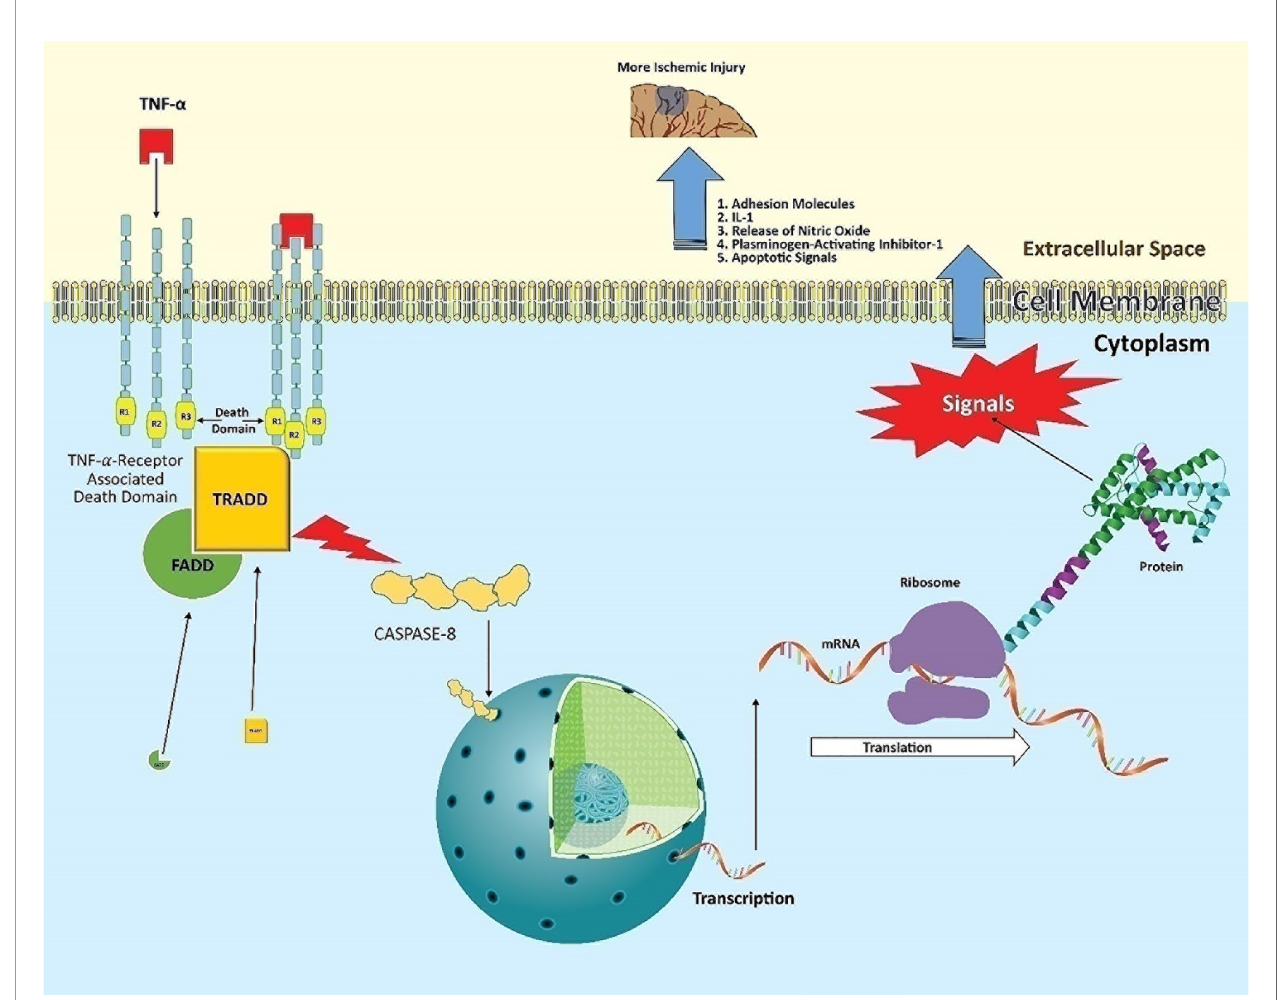
FIGURE 1 | Post-stroke neuroin fl ammatory pathway of TNF. TNF released from activated microglia binds to the trimeric TNFR1, primarily present on in fi ltrating leukocytes. This allows the intracellular part of the receptor to complex with the adaptor proteins TRADD and FADD via its death domain. This domain activates cytoplasmic caspase-8 enzyme. Activated caspase-8 acts as a transcriptional factor, entering the nucleus to induce target genes. The expressed mRNA encodes proteins such as adhesion molecules, IL-1, nitric oxide synthase (nNOS), plasminogen-activating inhibitor-1, and apoptosis-inducing factors. This ‘ mix ’ contributes to the neuronal damage in ischemic tissue following